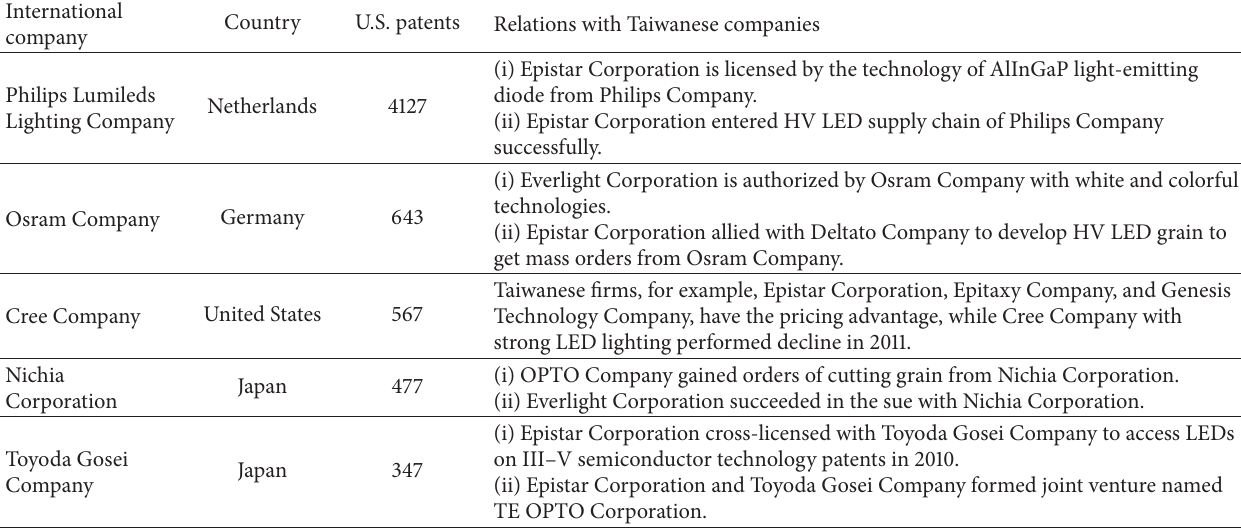
Table 4: Relations between international LED companies and Taiwan LED